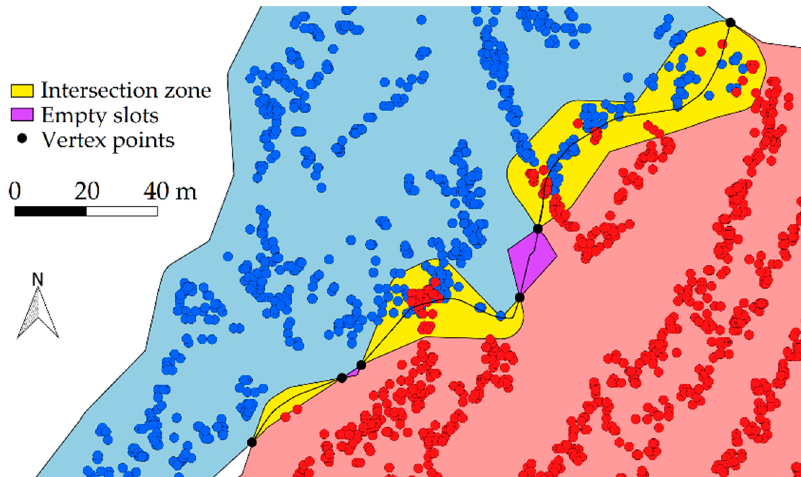
Figure 8. A new, solid stand boundary is created between the intersecting stands. The intersection zone and the small slot between the intersections are split and merged into stands. Note that the other small slot is smaller than A min and therefore not split, but only merged into one of the stands (here to the blue stand at left). Harvester was known to have a less accurate GNSS receiver. The ETRS-TM35FIN (EPSG:3067) coordinate system is used in the figure.